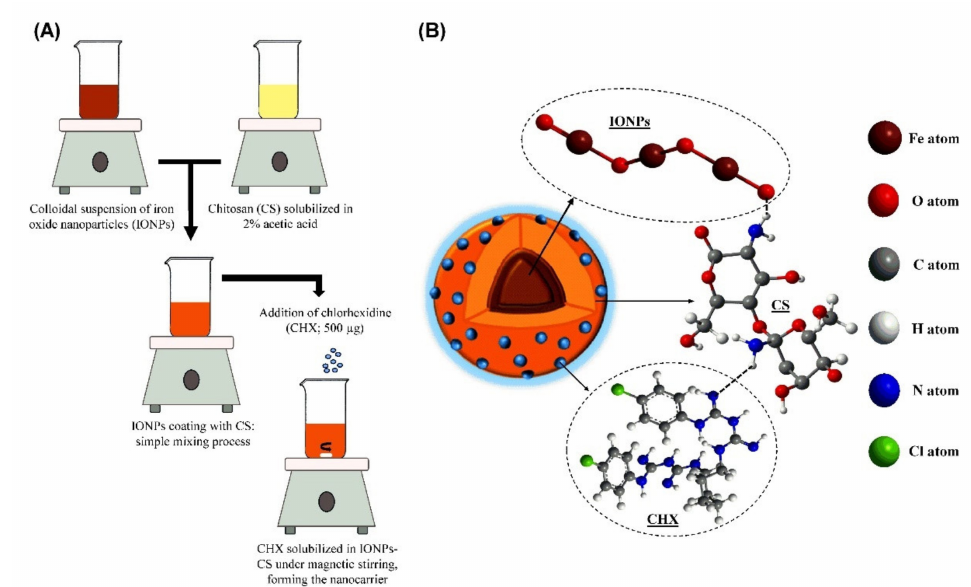
Figure 18. Schematic illustration of the steps involved in the preparation of the nanocarrier of chlorhexidine ( A ) and the plausible mechanisms of its formation ( B ). A colloidal suspension of iron oxide nanoparticles (IONPs) was mixed with chitosan (CS) previously solubilized in 2% acetic acid. After, chlorhexidine (CHX; 500 µ g) was solubilized in CS-coated IONPs, and the suspension was stirred for 1 h to allow the nanocarrier formation. The amino group of CS interacts with both oxygen from IONPs and imine nitrogen group from CHX [126]. Reproduced with permission from Elsevier